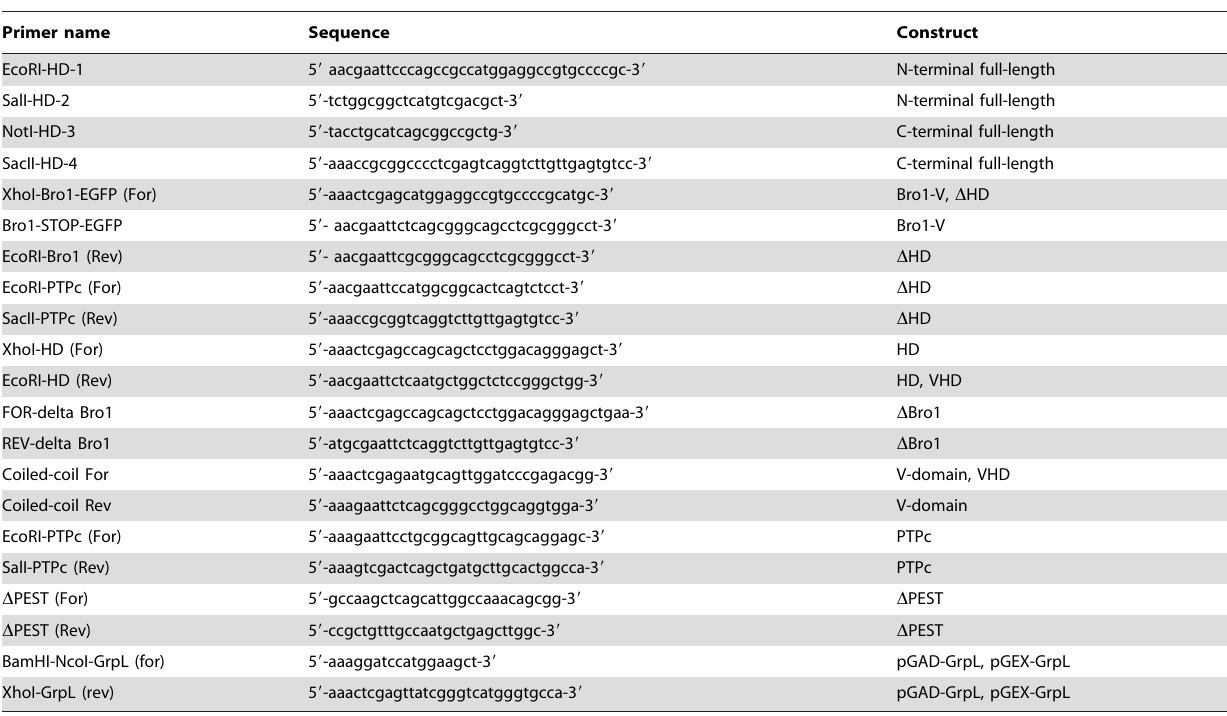
Table 1. PCR primer